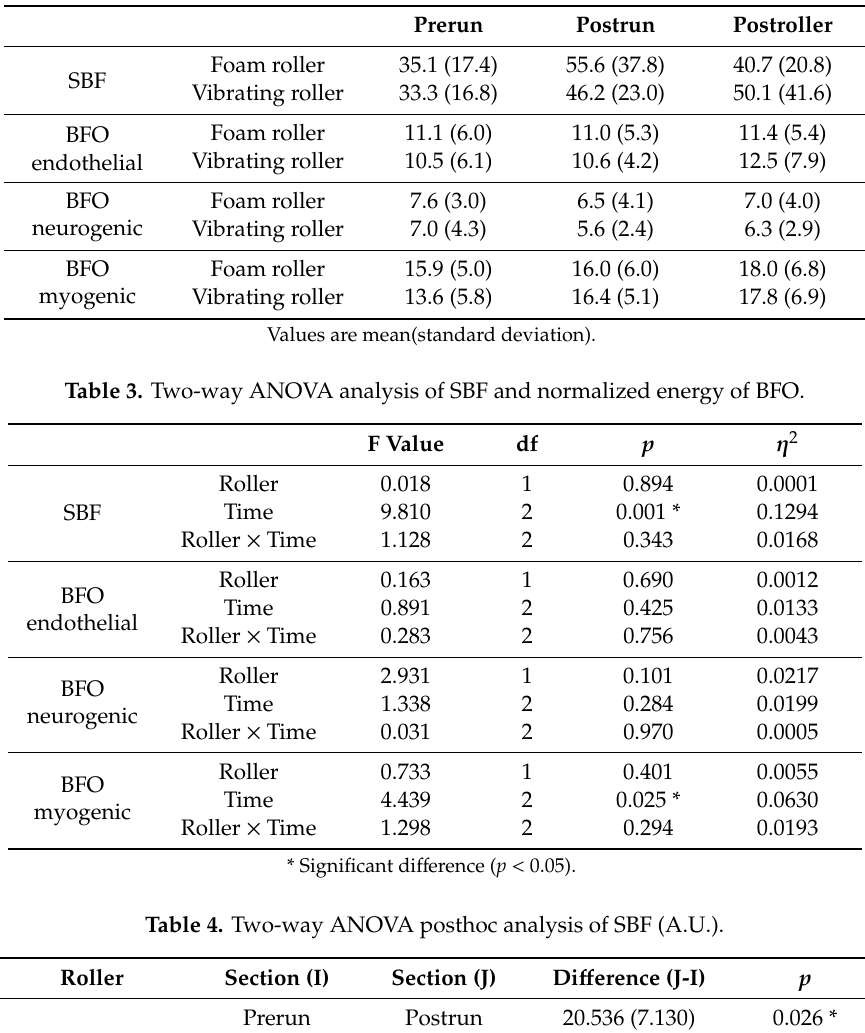
Table 2. The experimental result of skin blood flow (SBF; A.U.) and normalized energy of blood flow oscillation (BFO; %).